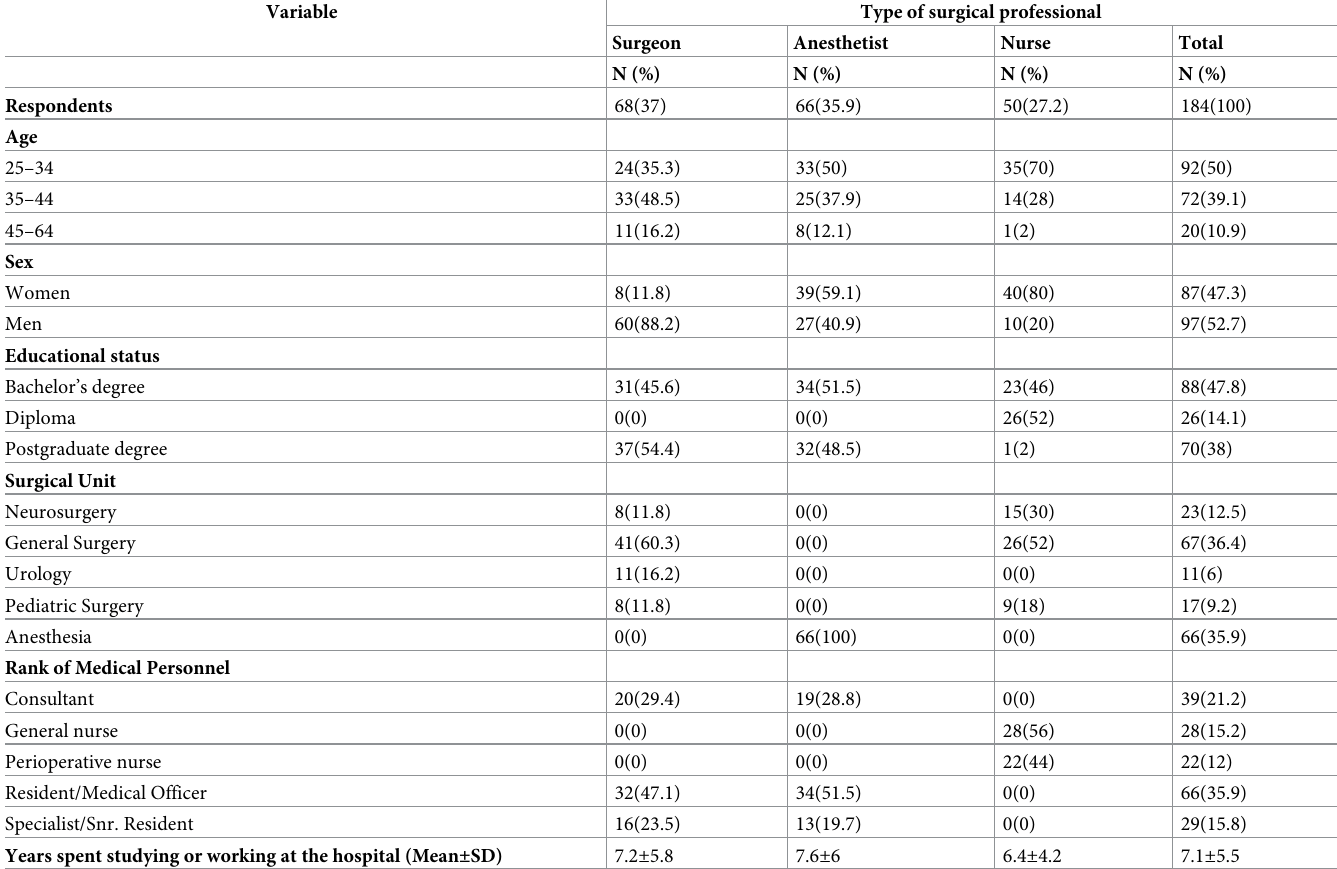
Table 1. Background characteristics of surgical